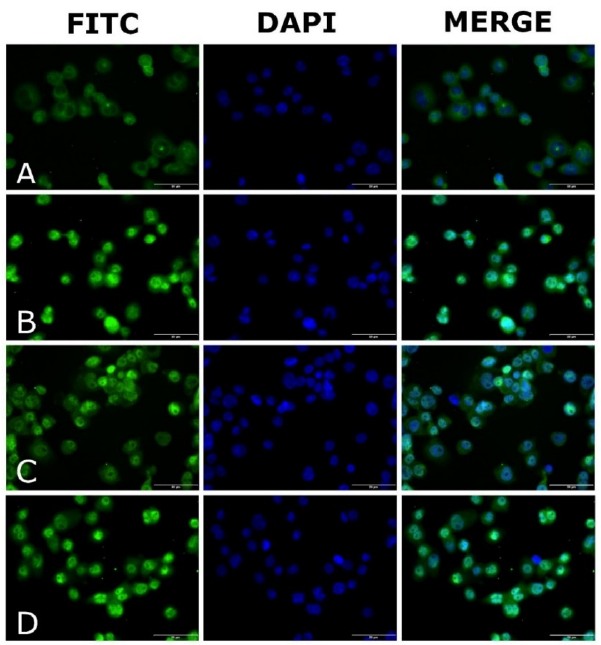
Figure 7. The activity of complex 5 and prednisone on NF- κ B translocation. THP-1 cells differenti- ated into macrophages were pre-treated with 5 (200 nM) ( C ), prednisone (200 nM) ( D ) or DMF (0.1% v/v ) ( A = negative control, B = positive control) for 1 h. LPS was used for activation of NF- κ B migration ( B – D ). The NF- κ B translocation was observed by fluorescent microscope after 1 h of stimulation with LPS, the intensity of fluorescence reflects the measure of NF- κ B translocation. FITC = NF- κ B staining (green); DAPI = nucleus DNA staining (blue).